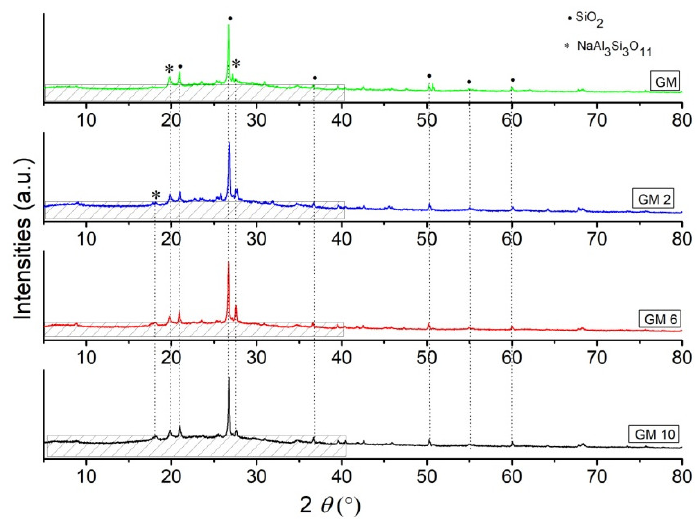
Figure 2. XRD diffraction patterns of GM, GM2, GM6, and GM10.